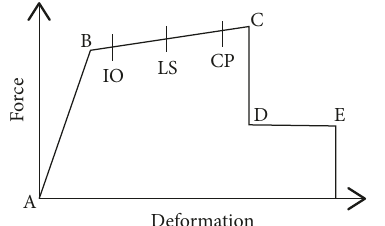
Figure 3: Force-deformation for pushover analysis.